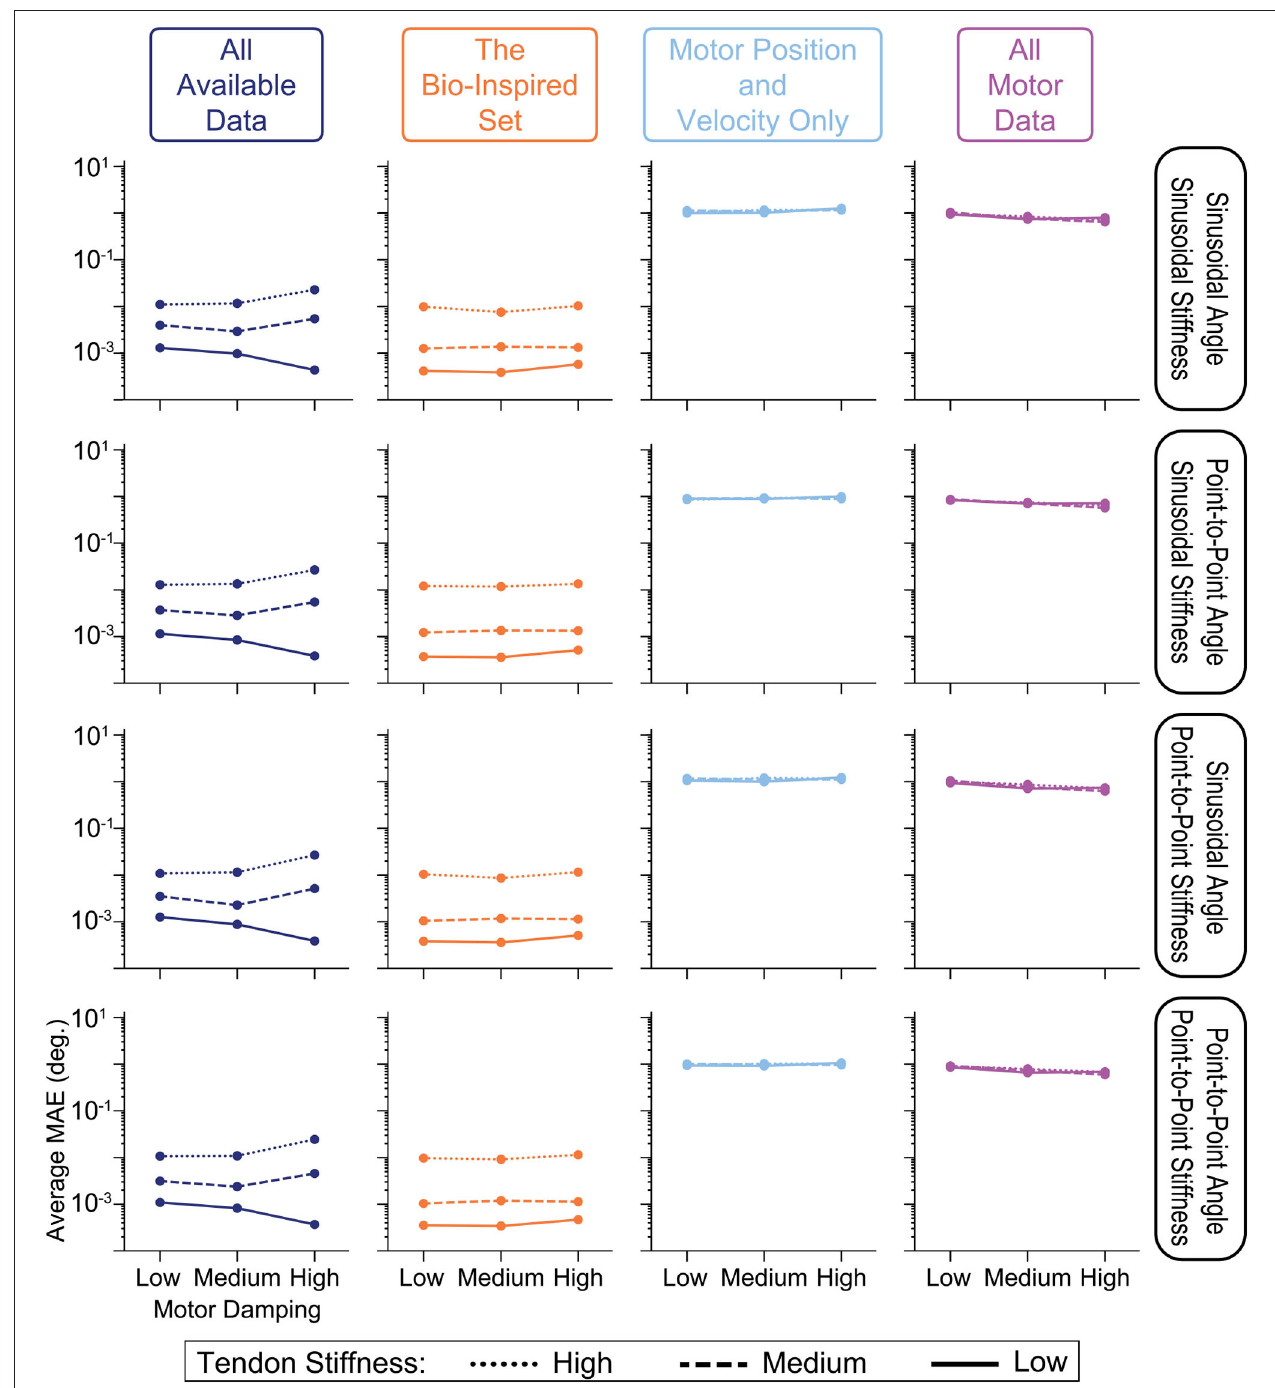
FIGURE 13 | Comparing the average performance of ANNs designed to predict joint angles from one of four sensory sets when motor damping ( x-axis ) and tendon stiffness ( line style ) are varied. We see from the vertical separation of the lines in the left two columns that ANNs trained with tendon tension information perform worse as tendons become more inextensible—a trend not observed in the ANNs trained with motor information only ( right two columns ). Additionally, there appears to be no trends in performance with respect to motor damping except for those ANNs trained with all motor data (including acceleration, right column ) or the set of All Available Data when tendon stiffness is Low , which intuitively makes sense as higher damping may mean more useful information in the motor acceleration data.